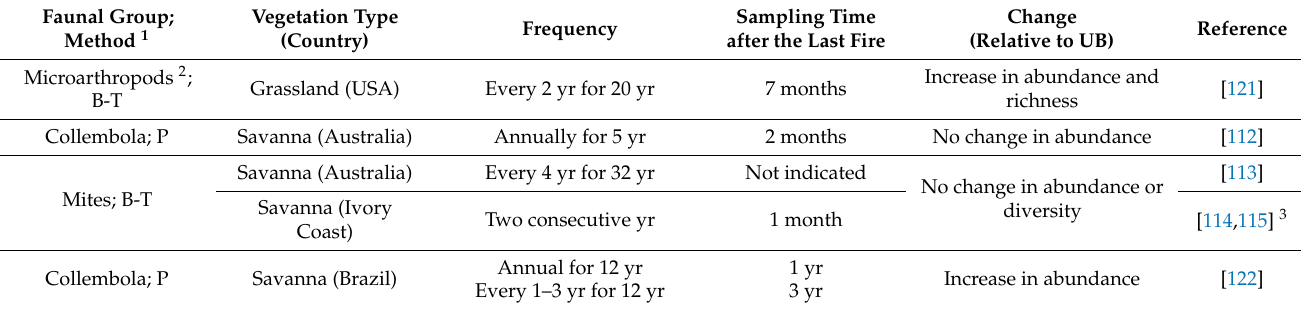
Table 9. Studies including effects of repeated prescribed fires on soil mesofauna. UB: unburned soil; yr: year. Faunal Group; Method